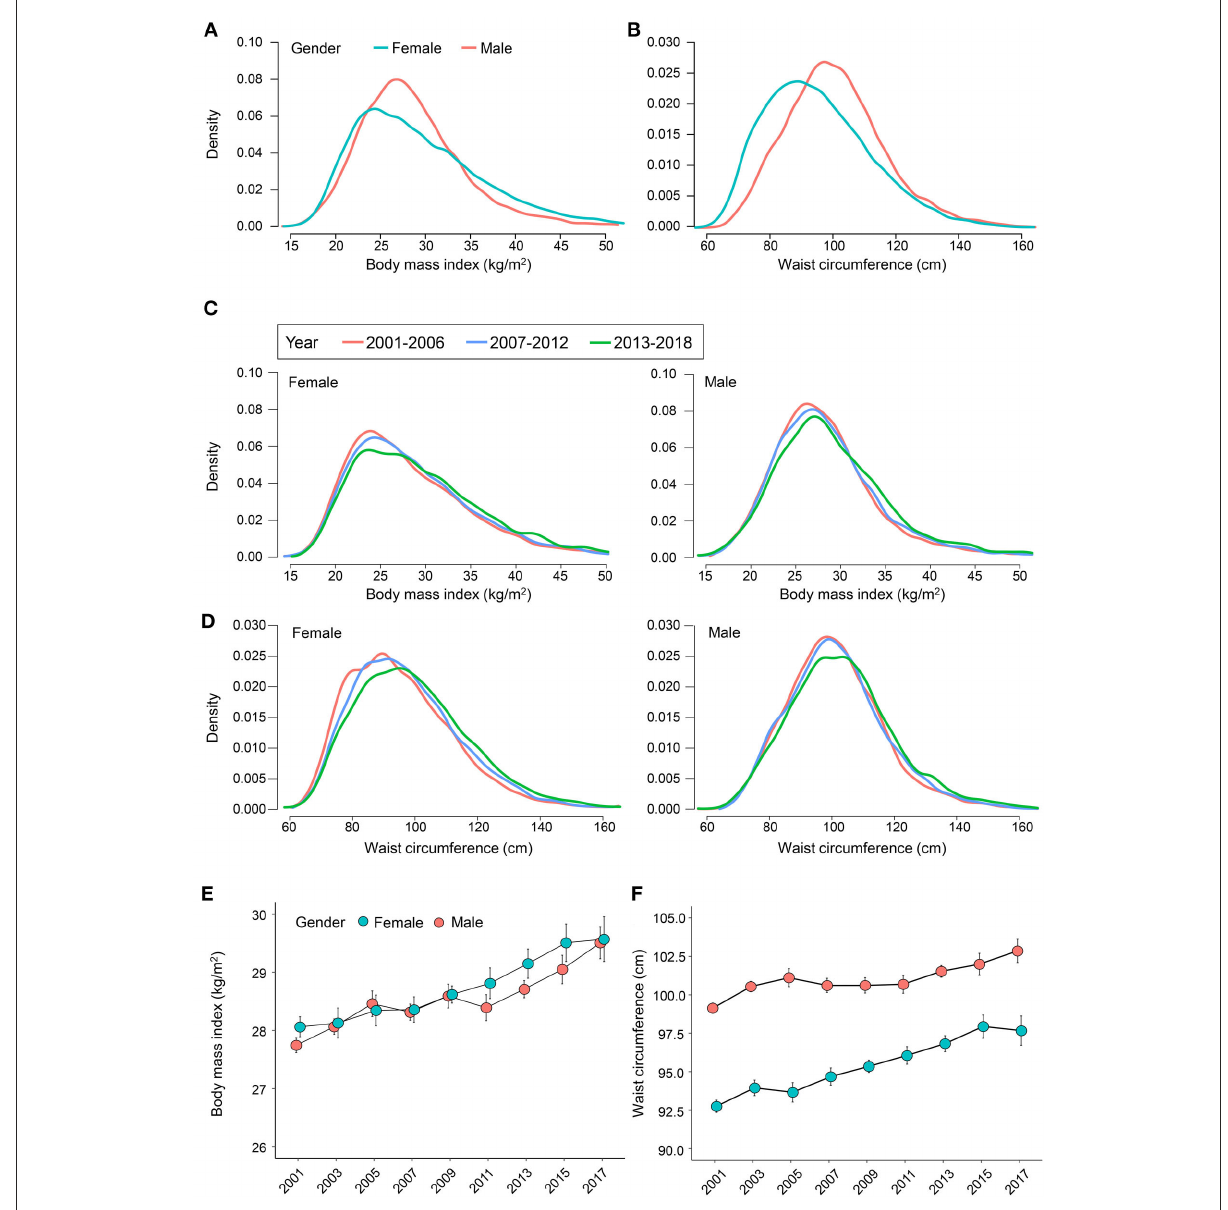
FIGURE1 Distribution trend of body mass index and waist circumference during 2001–2018. The sex-specific distribution of (A) body mass index and (B) waist circumference. The sex-specific distribution of (C) body mass index and (D) waist circumference in 2001–2006, 2007–2012, and 2013–2018. The mean age-adjusted (E) body mass index and (F) waist circumference from 2001 to 2018. The weighted study design is considered in the